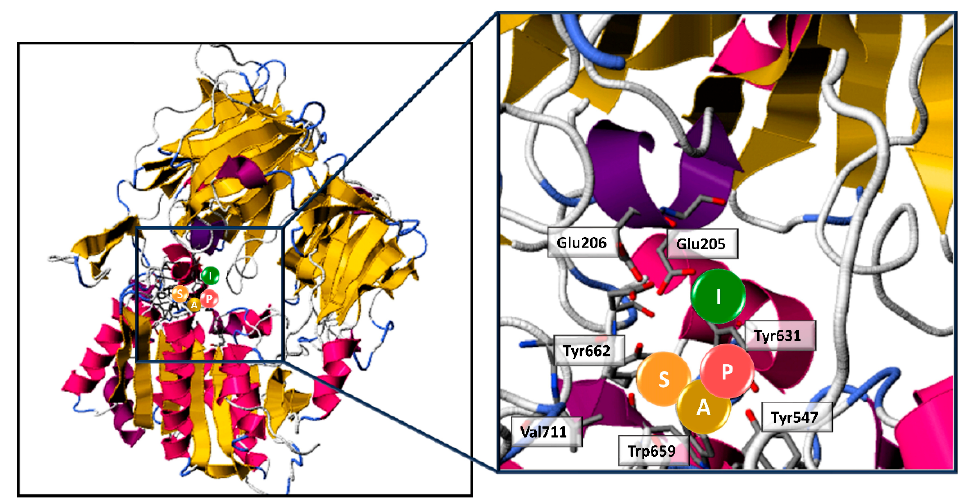
Figure 3. PepSite2 DPP-IV-SAPI binding modelling. Peptide binding site prediction of DPP-IV enzyme (PDB ID entry code: 1NU6) with SAPI. The insert shows the amino acids in the DPP-IV subsites S1 and S2 interacting with the tetra-peptides SAPI.